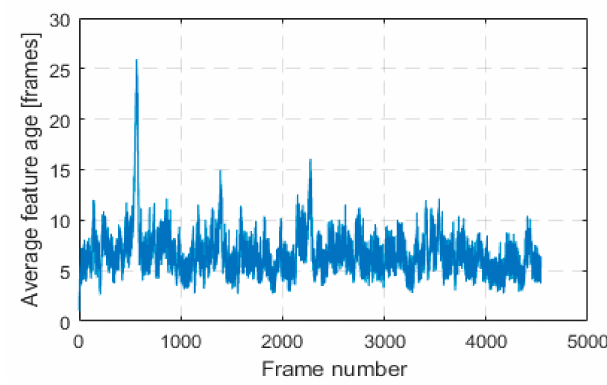
Figure 3. Average feature age in each frame of KITTI sequence 00.